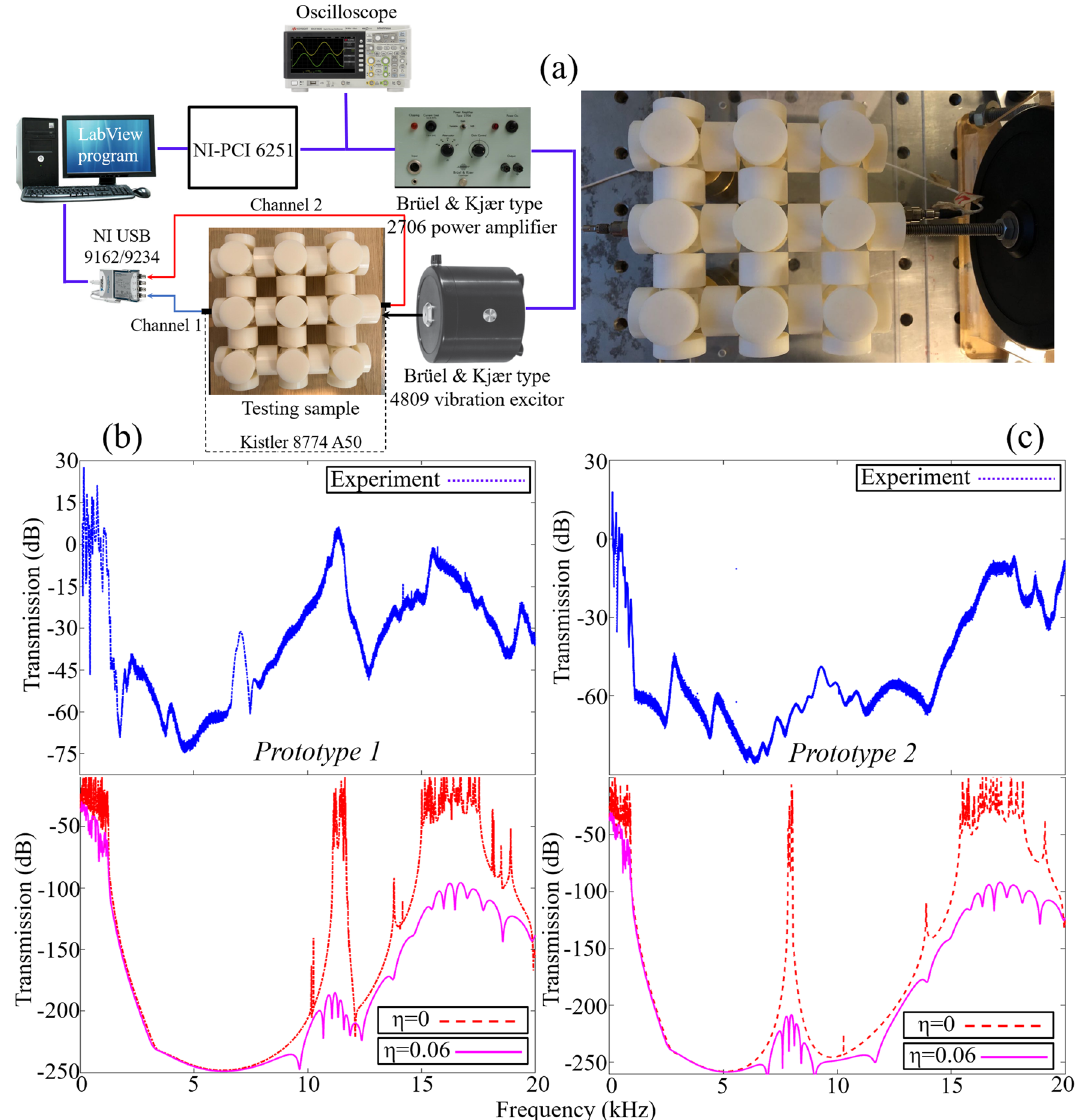
Figure 6. ( a ) Experiment setup; ( b , c ) Prototype 1 and Prototype 2 experiment and numerical result. For numerical transmission curve, the effect of material loss factor is η = 0.06 . Excellent agreement between numerical and experiment result is